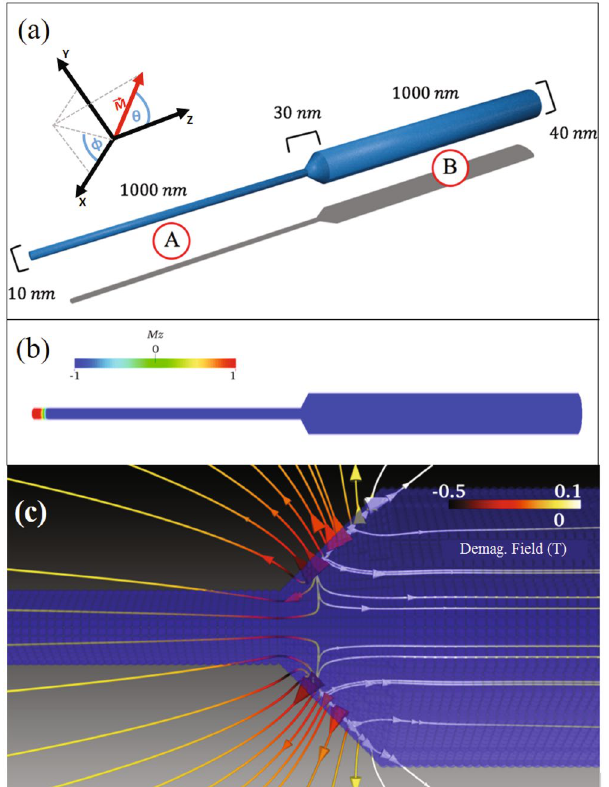
Figure 3. ( a ) Geometrical characterization of the simulated nanowire with modulated diameter. ( b ) Initial state of the system: a TDW moves due to the application of a electron flow in + z direction. ( c ) Demagnetizing field lines in the transition zone of the modulated